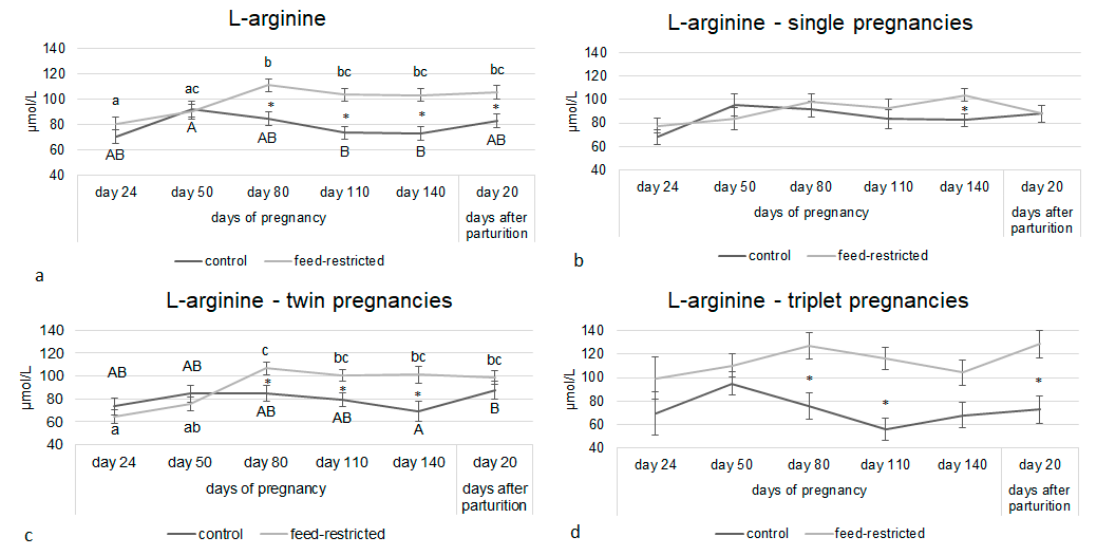
Figure 2. L-arginine circulating concentrations from day 24 of pregnancy to day 20 after parturition in control and feed-restricted ewes ( a ) carrying single fetuses ( b ), twins ( c ), and triplets ( d ). Asterisks indicate significant differences between control and feed-restricted ewes. Different letters indicate significant differences within the same group: Upper-case letters for control group and lower-case letters for feed-restricted group. ANCOVA * p < 0.05.